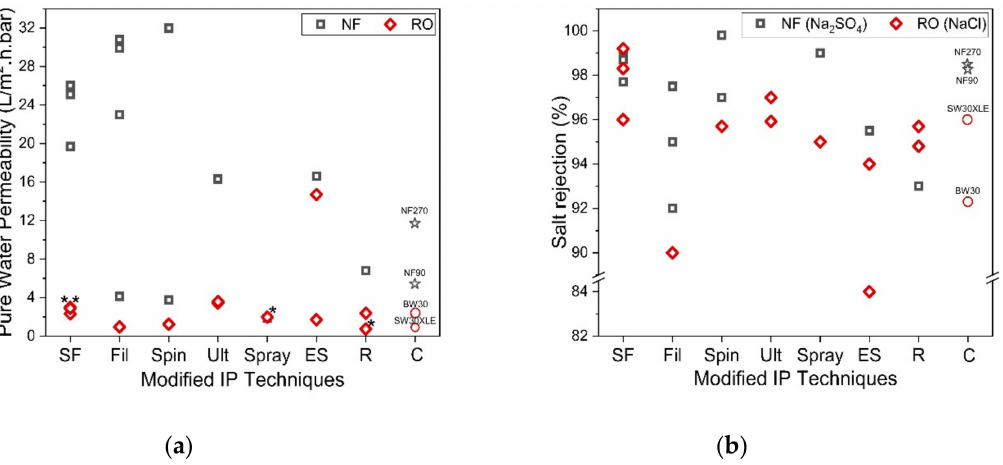
Figure 13. ( a ) Comparison of membrane permeability fabricated by using support-free IP (SF) [63,76,77,81–83], filtration-based IP (Fil) [29,87–90], spin-based IP (Spin) [30,97,98], ultrasound-based IP (Ult) [101,102], spray-based IP (Spray) [112,113], electrospray-based IP (ES) [31,126,127], reverse IP (R) [80,129,130] and commercial membrane (C) and ( b ) Comparison of salt rejection (Na 2 SO 4 for NF and NaCl for RO) for each novel IP technique. (* Note: The data were obtained from water permeability of 2000 ppm NaCl solution).